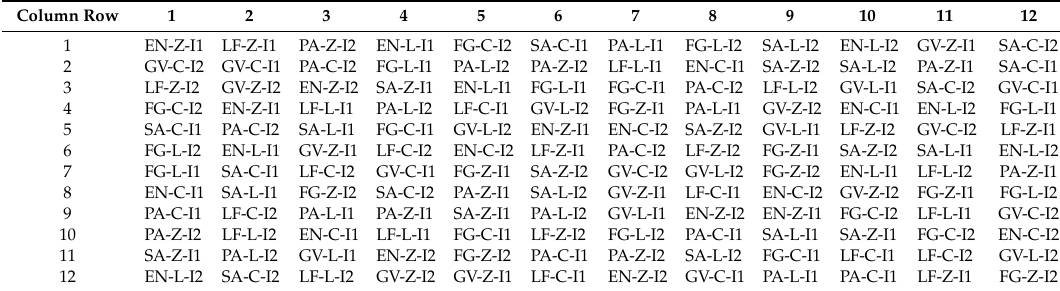
Table 1. Living wall experiment